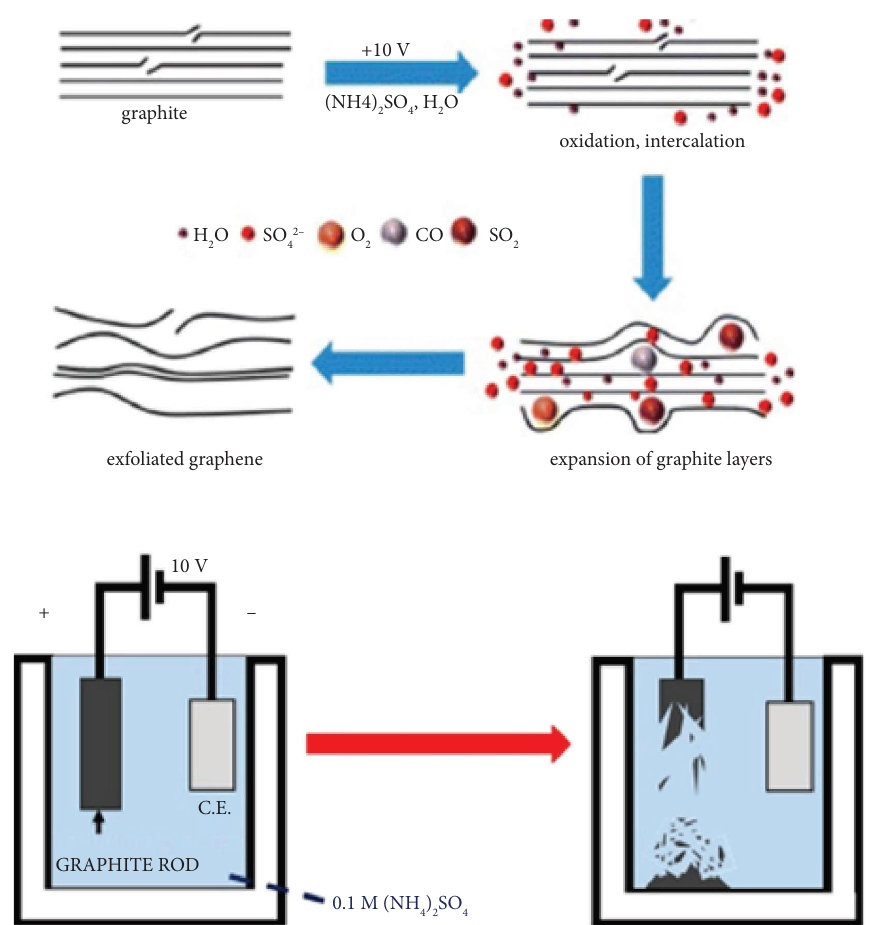
Figure 8: Electrochemical exfoliation mechanism and equipment setup for electrochemical exfoliation